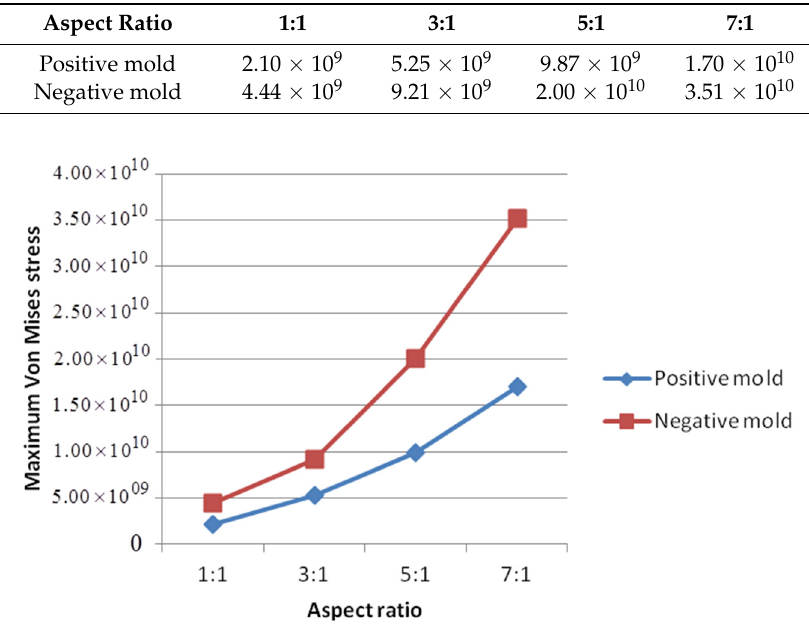
Table 4. Comparison of maximum Von Mises stresses for positive and negative molds (units of Pa).